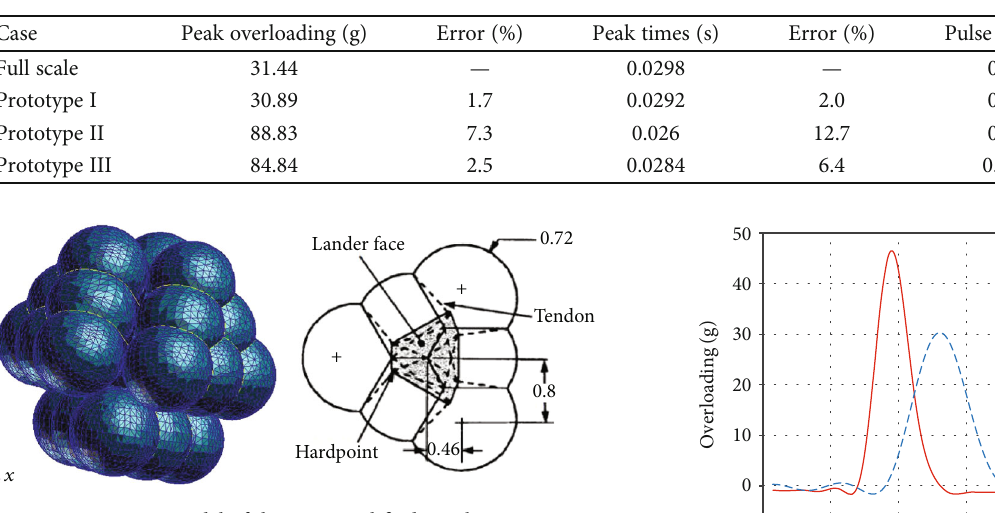
Figure 3: Comparison of the overloading. Table 3: Comparison of the overloading for the full-scale system and the prototype.